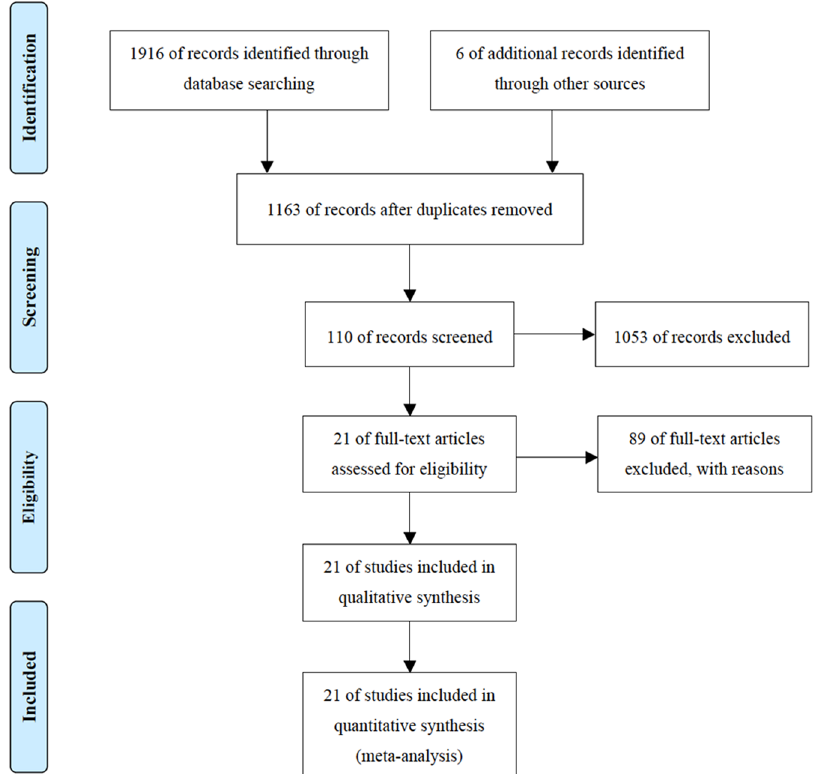
Figure 1. Flow of information through the different phases of the meta-analysis. From: Moher, D., Liberati, A., Tetzlaff, J. & Altman, D. G. Preferred reporting items for systematic reviews and meta-analyses: the